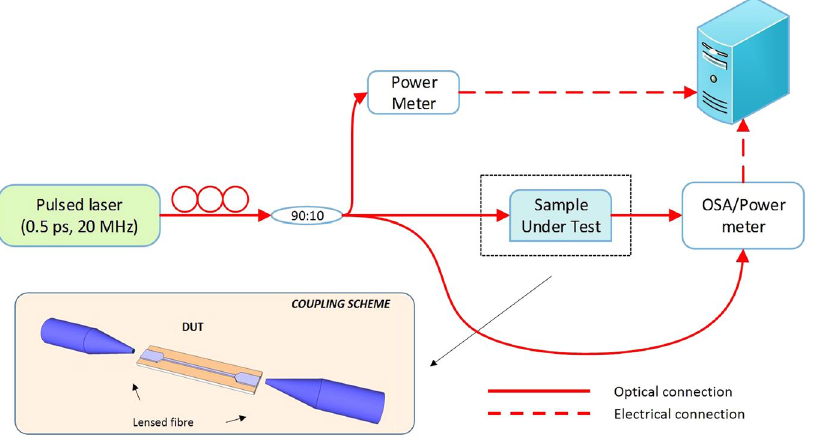
Figure 8. TPA experimental